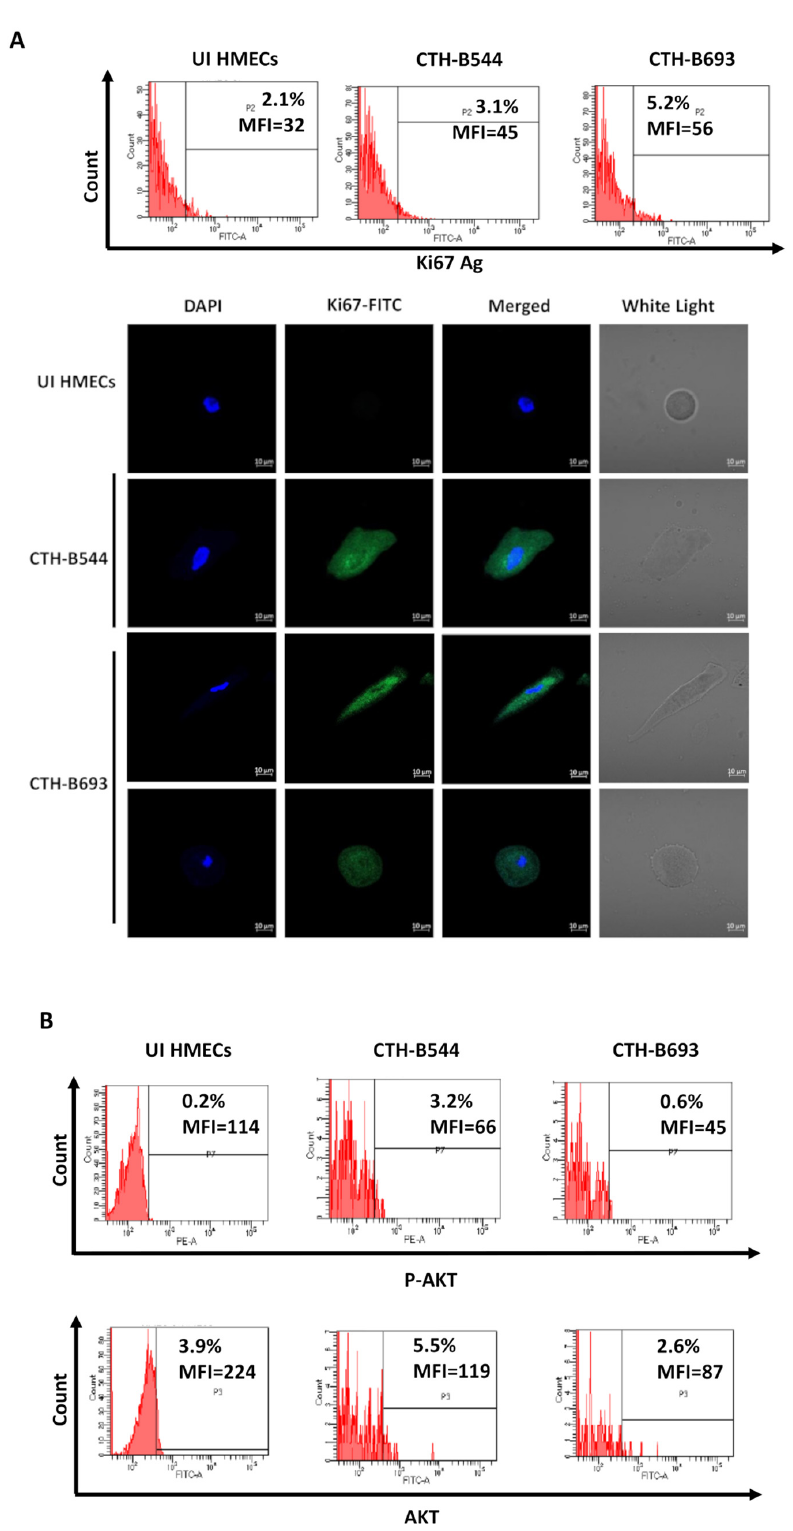
Figure 3. CTH proliferation capacities and AKT activation. ( A ) Proliferation assessment by FACS and confocal microscopy; UI HMECs, CTH-B544 and CTH-B693 cells were stained for Ki67 Ag and DAPI. Magnification ×63, scale bar 10 μ m. ( B ) P-AKT, and AKT expression in UI HMECs and CTH cells, as measured by FACS. Results are representative of three independent experiments.